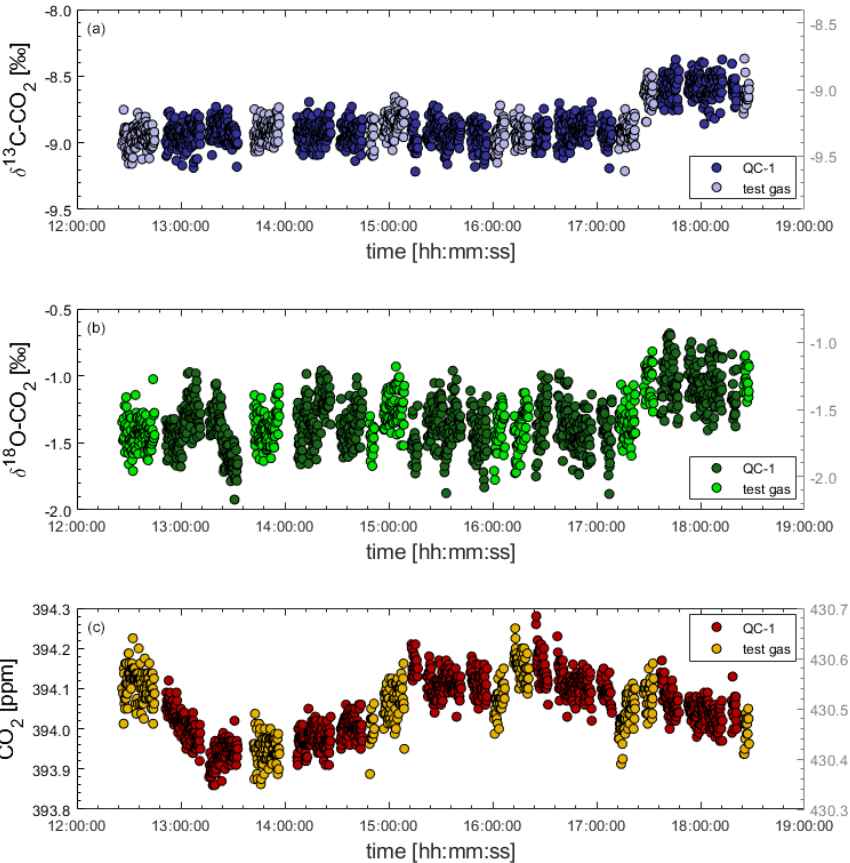
Figure 4. Sudden and synchronous shift in both δ 13 C-CO 2 (a) and δ 18 O-CO 2 (b) affecting the measurement of two gases (QC-1 and another test gas cylinder) during laboratory tests. Shifts in isotope traces are not reflected in CO 2 mole fractions (c) . Causes of the isotope shifts are